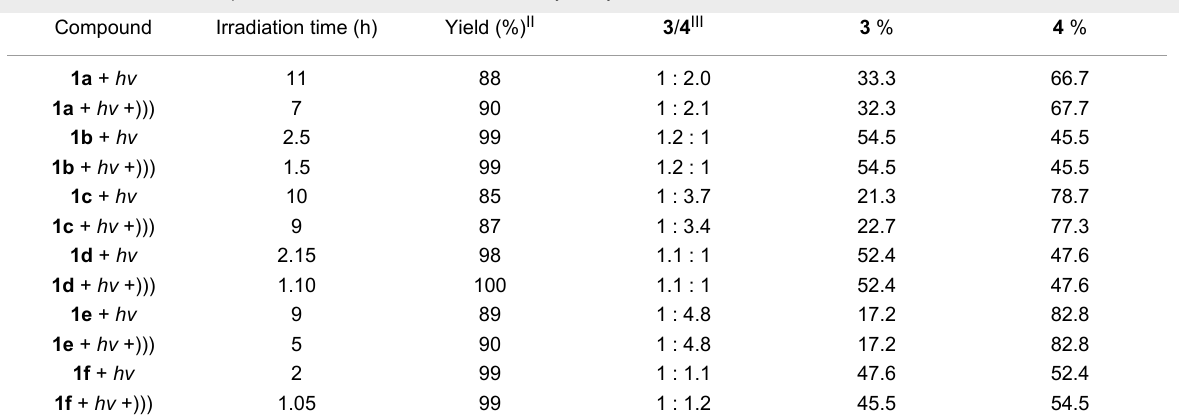
Table 1: Photochemical and photosonochemical reactions of 1a-f catalyzed by 2 in methanol solution. I Compound